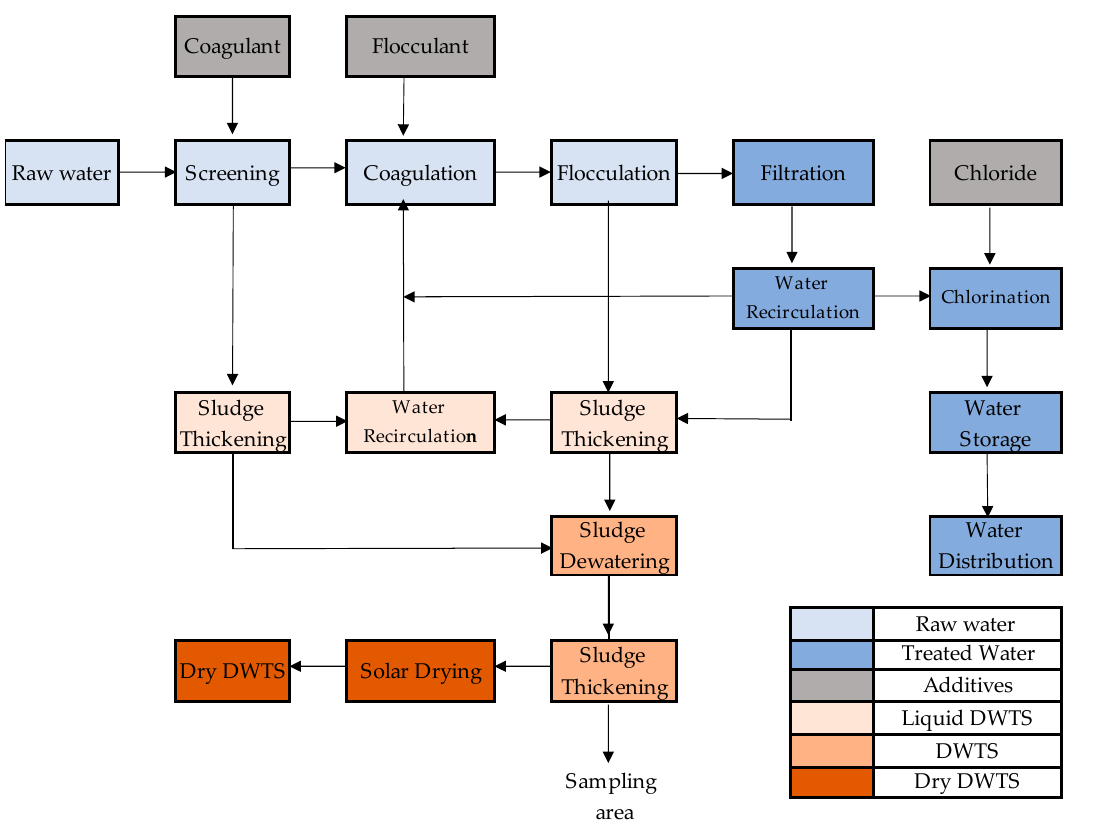
Figure 1. DWTS Production Plan in Marrakech. The samples were taken from the sludge storage tank, in which the thickened and pressed sediment streams of the primary and secondary treatments and the back-washing of the filters converge; a picture of the sludge is shown in Figure 2.